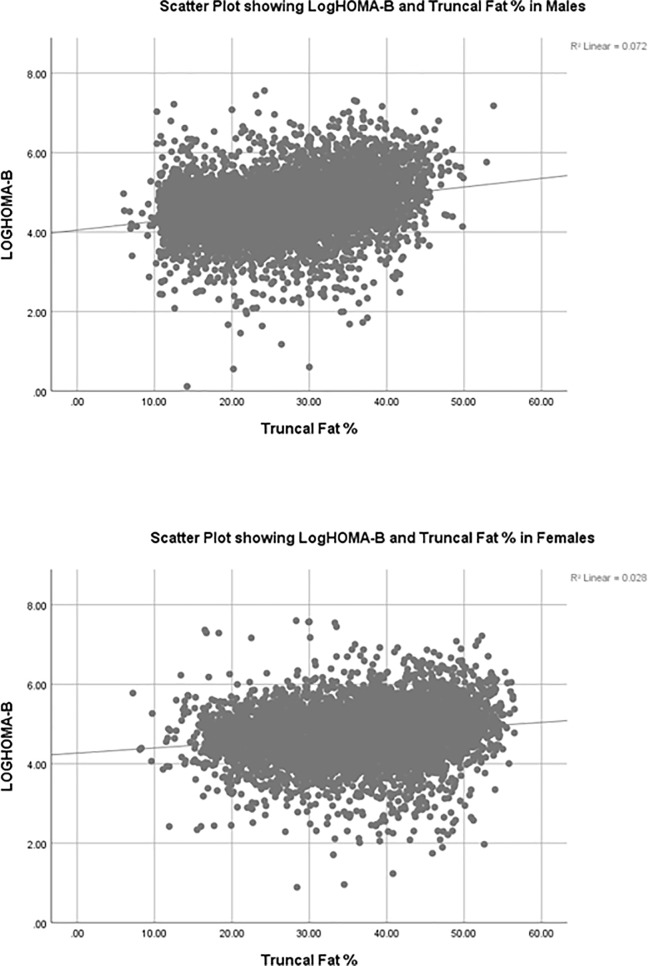
The scatter plots outlining the relationship between log HOMA-β and trucal fat % in males and females.